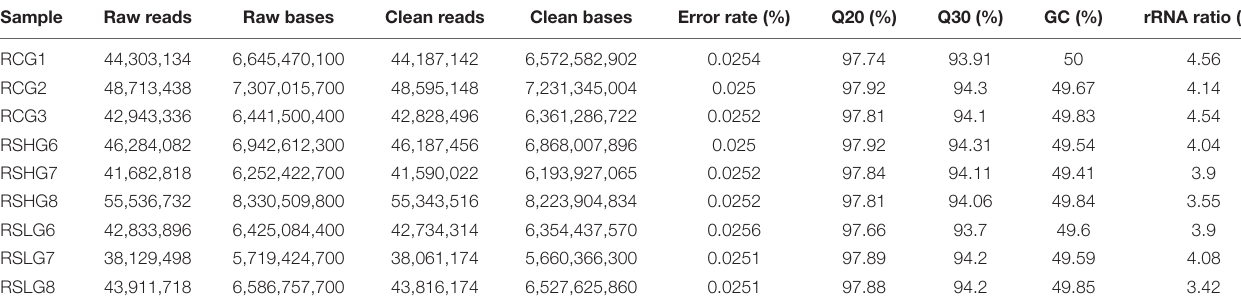
TABLE 2 | Information of transcriptomic reads of each sample.